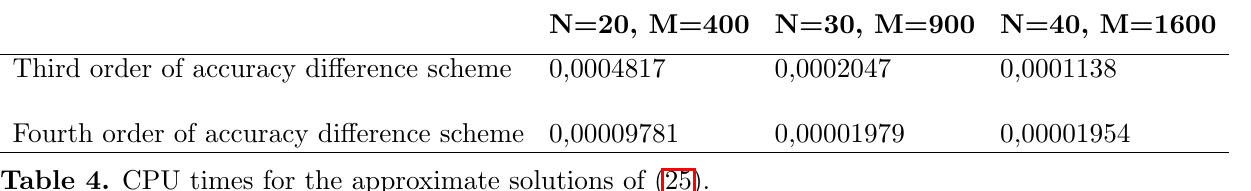
Table 4. CPU times for the approximate solutions of (25).